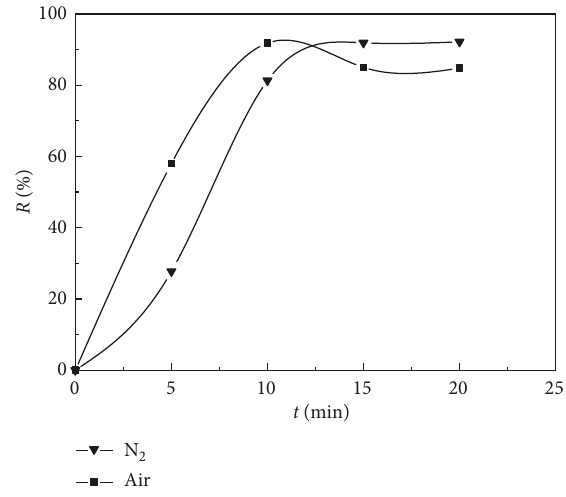
Figure 5: Plot of reduction degree of pellets under different at- mospheres at 1200 ° C against